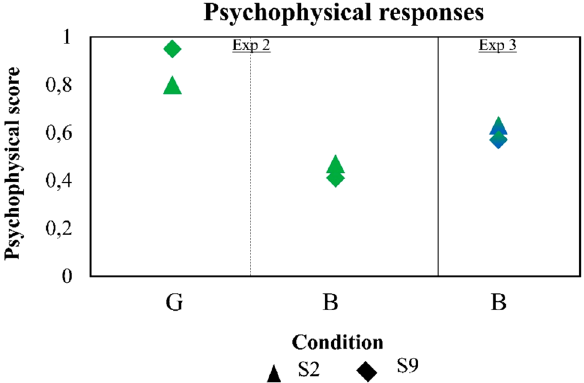
Figure 4. Results from the control experiment using narrow spectral bandwidth stimuli. Normalized psychophysical score of the perceived quality of natural images (555 nm for G, 480 nm for B, 5-nm spectral bandwidth), for experiments equivalent to Exp 2 and Exp 3. Exp 2 Green stands for green stimuli at best focus, Exp 2_B stands for green stimulus defocused by − 0.87 D with respect to the best focus in G, and Exp 3 Blue stands for blue stimulus at the best focus in G. Data are for two subjects (S2,